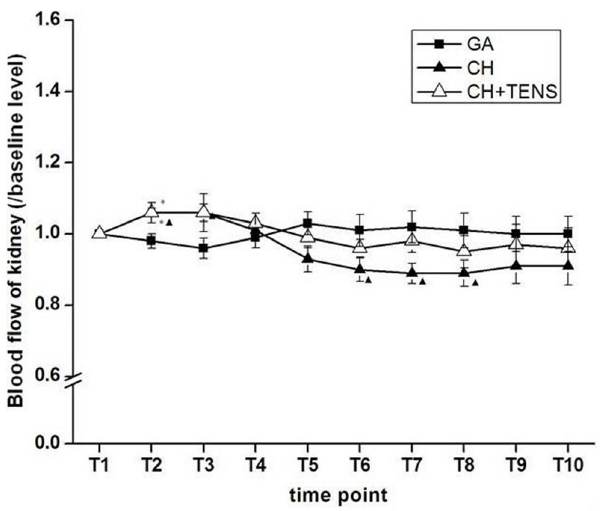
Figure 4. Blood flow to the kidney during controlled hypoten- sion (CH). Renal blood flow in the CH group decreased significantly compared with baseline at the end of the maintenance stage (T 6 ) and during MAP restoration (T 7 –T 8 ). TENS significantly prevented the low perfusion to the kidney in this period. Data are presented as mean 6 standard error of the mean. * P , 0.05 vs. general anesthesia (GA) group, m P , 0.05 vs. basal level, n=6 per group.